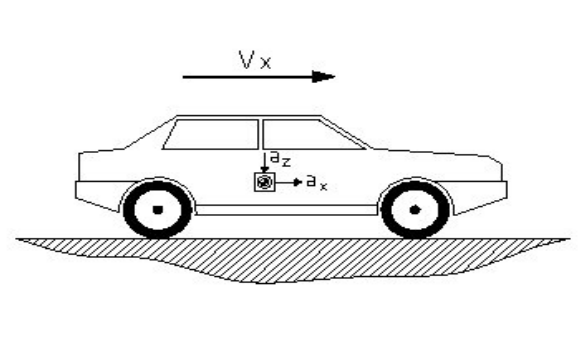
Figure 5. Representation of the vehicle under performance tests.